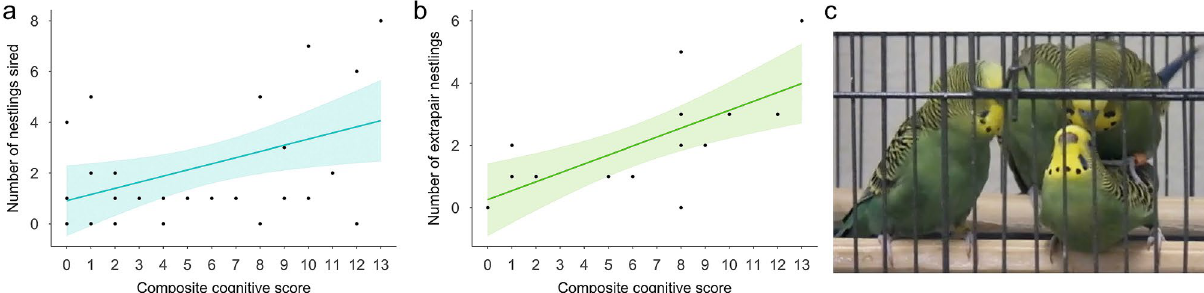
Figure 2. Males with higher composite cognitive scores sire more nestlings. ( a ) Relationship between male composite cognitive score and number of nestlings sired ( N = 30). ( b ) Relationship between male composite cognitive score and number of extra-pair nestlings. Only males that were paired during the breeding phase were included ( N = 15). Shaded areas represent 95% confidence intervals from the generalized linear models. ( c ) A female budgerigar engaged in an extra-pair copulation next to her social mate (left).